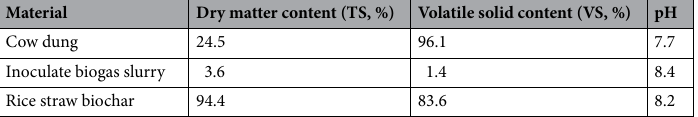
Table 1. Basic properties of raw